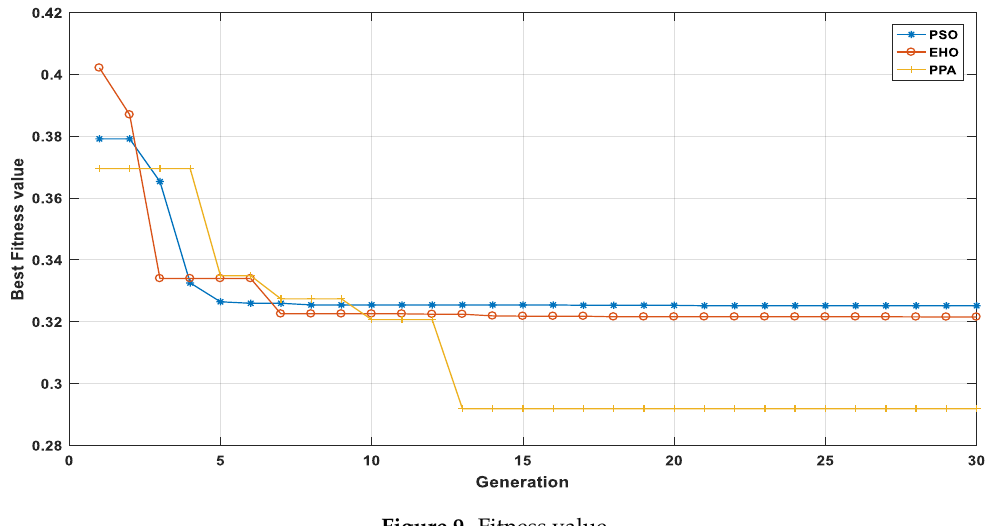
Figure 9. Fitness value.